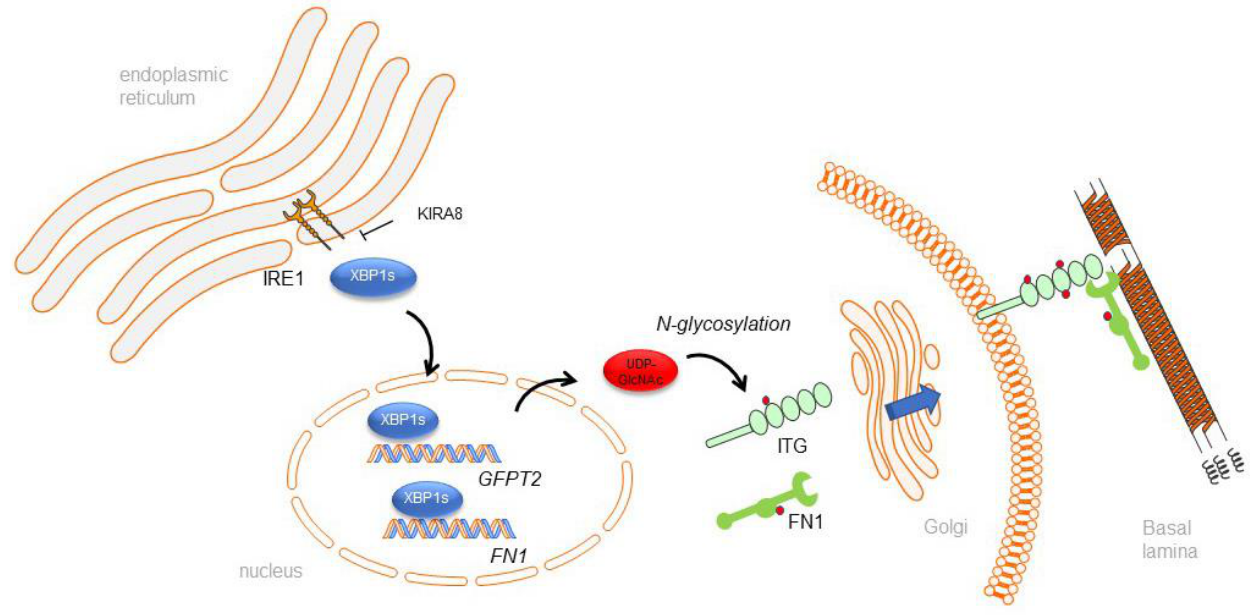
Figure 7. RSV induced N-glycosylation is mediated by the IRE1 α –XBP1 arm of the UPR. A schematic view of the relationship between the IRE1 α –XBP1 pathway of the unfolded protein response, ac- cumulation of UDP-GlcNAc, protein N glycosylation, and remodeling of the basal lamina. IRE1 activated in the ER induces alternative splicing and produces the formation of activated XBP1s, which is a transcription factor controlling the expression of the hexosamine biosynthetic pathway, integrin (ITG), and ECM components, including fibronectin 1 (FN1). UDP-GlcNAc is a rate-limiting enzyme for protein N-glycosylation. After processing through the Golgi, glycosylated ECM components are presented on the cell surface and contribute to remodeling of the basal lamina.